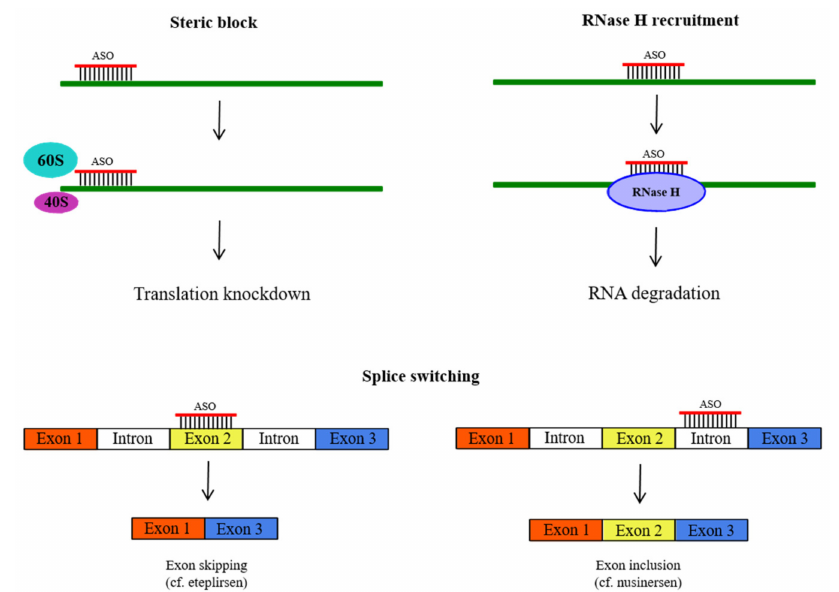
Figure 1. The aspects of the antisense